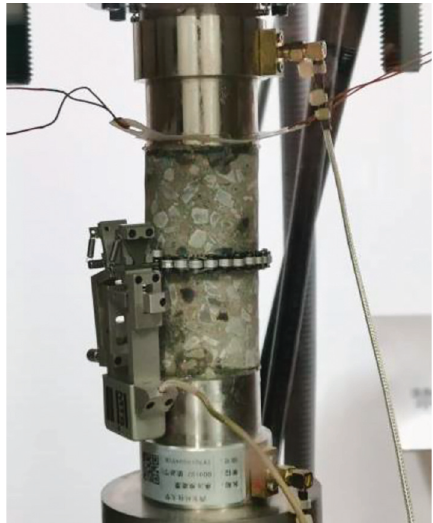
Figure 2: Uniaxial loading of concrete